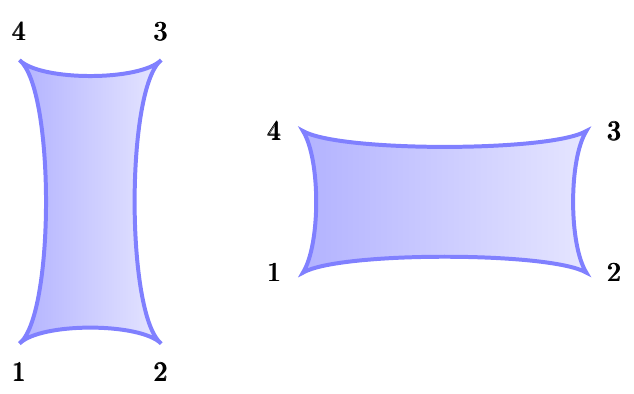
Figure 2 . Stretching of an hyperbolic quadrilateral. All the edges are geodetics on a hyperbolic Riemann